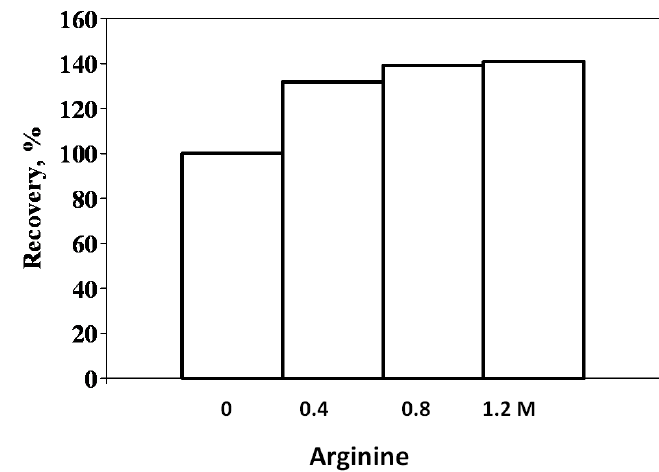
Figure 5. Effect of arginine on refolding of IL-6 by C12- L